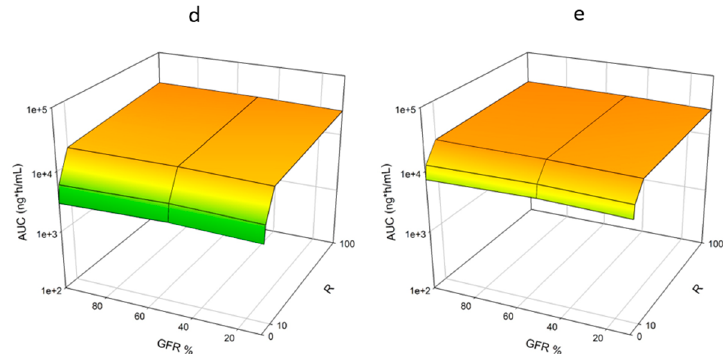
Figure 4. Impact of Competitive Inhibition and Enzyme Expression on AUC of Nifedipine. Simulations were performed incorporating competitive inhibition through the factor R ([I]/ K i ). R was varied from 0 to 100. Expression of CYP3A4 was also varied ± 2- and ± 5-fold. A dose of 60 mg was administered orally to an exclusively male population in a fasted state. Simulations included ten trials with ten individuals in each. Age ranged from 21 to 65 years, and simulations were conducted with varying the degrees of RI by utilizing the following populations, Sim-Healthy Volunteers, Sim-RenalGFR_30-60, and Sim-RenalGFR_less_30 to represent 100%, 50% and 10% GFR. ( a ) Original CYP3A4 expression; ( b ) +2 ‐ fold CYP3A4 expression; ( c ) +5 ‐ fold CYP3A4 expression; ( d ) − 2 ‐ fold CYP3A4 expression; ( e ) − 5 ‐ fold CYP3A4 expression.